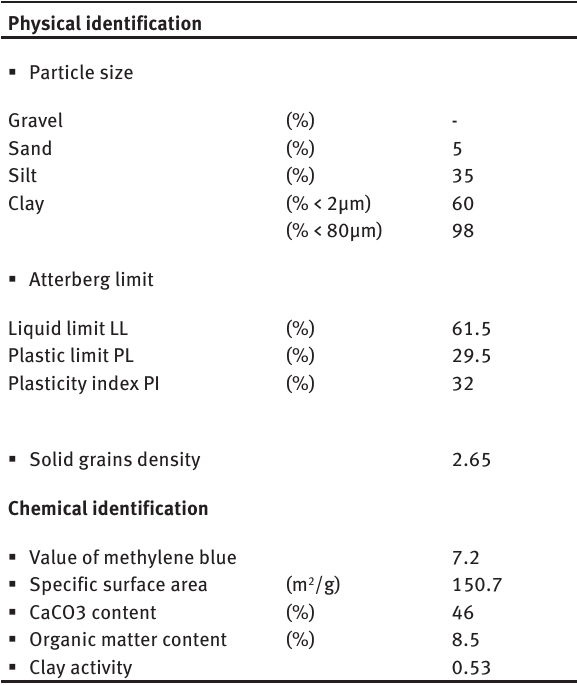
Table 2 : Physical and chemical properties of the studied